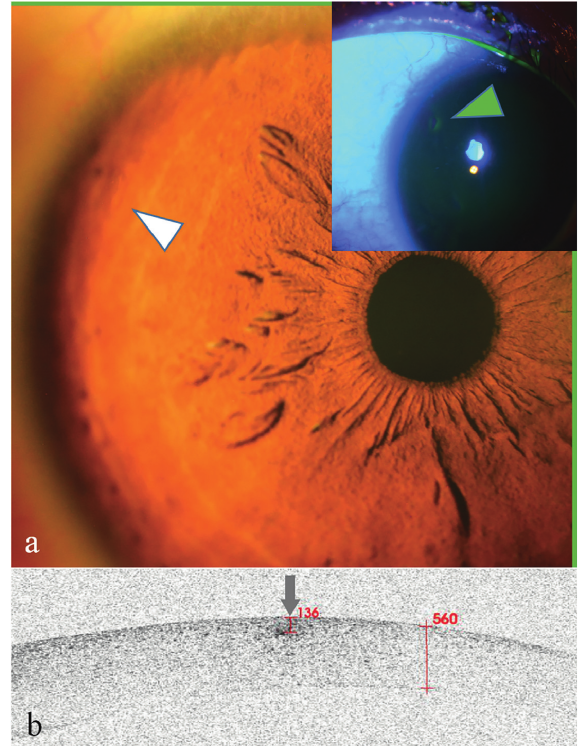
Figure 5: Anterior segment and AS-OCT image for Case 5. (a) Anterior segment photograph showing a patchy cloud-like haze over the cornea and a cloudy milky lump in front of the pupil (arrowhead). (b) AS-OCT scanning showed there was a lesion of high signal with blurred boundary (arrow) followed by a central zone shadowing effect (star). The lesion had a diameter of 1372 μ m. The corneal thickness was 604 μ m, and the epithelial thickness was 102 μ m. A layer of continuous epithelium tissue was seen on the bottom of the lesion.